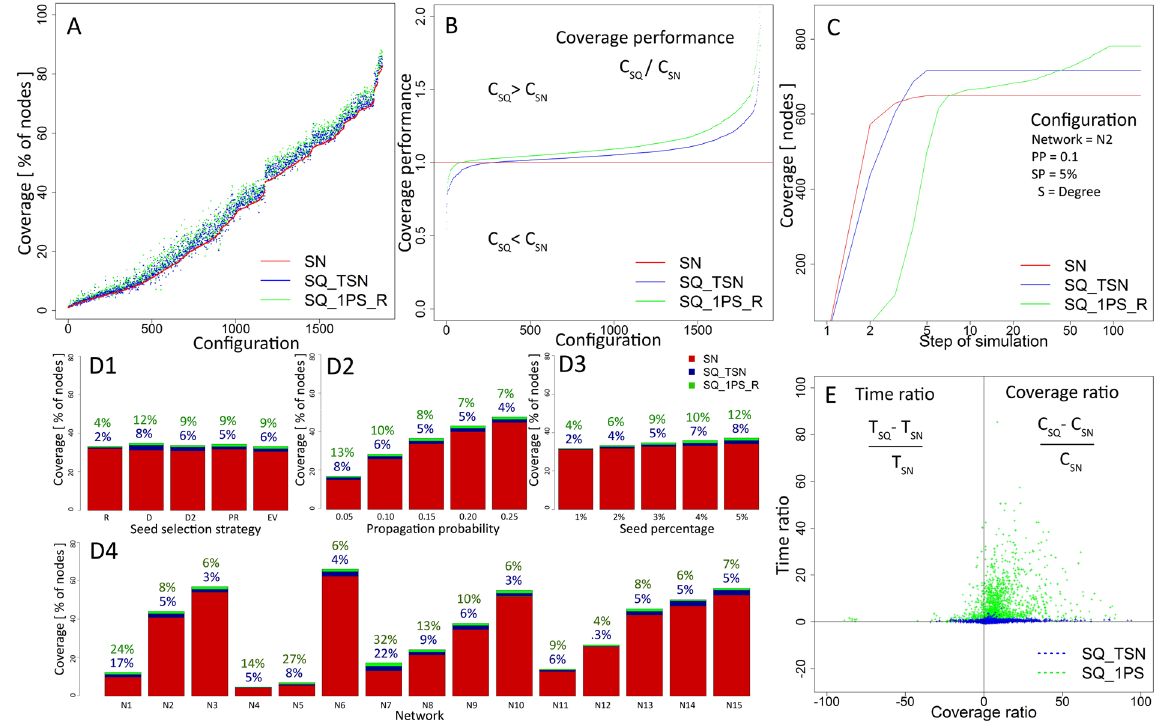
Figure 2. ( A ) Average coverage from all 1,875 configurations for k = 1 per stage seeding (SQ_1PS_R) and the sequential approach based on single stage time reference (SQ_TSN), compared with the single stage method (SN) for all simulation cases ordered by single stage coverage; ( B ) Performance of k = 1 per stage seeding (SQ_1PS_R) and reference time based seeding (SQ_TSN) in the relation to single stage (SN) for all configurations; ( C ) Cumulative coverage results from 100 steps of simulation with degree based ranking ( D ) for network N2 with propagation probability PP = 0.1 and seeding percentage SP = 5%; ( D1 ) Coverage increase for SQ_1PS_R and SQ_TSN based on various seed ranking methods: random R, degree D, second level degree D2, Page Rank PR, Eigenvector EV; red part shows single stage seeding (SN) coverage, blue part and font show sequential SQ_TSN improvement while green part and font show sequential SQ_1PS_R gain; ( D2 ) Coverage increase for SQ_1PS_R and SQ_TSN for all used propagation probabilities with values 0.05, 0.1, 0.15, 0.20 and 0.25; ( D3 ) Results for seed selection percentages from the range 1% to 5% for SQ_1PS_R and SQ_TSN; ( D4 ) Average coverage from single stage seeding together with coverage increase from sequential seeding SQ_1PS_R and SQ_TSN for networks N1–N15; ( E ) Distribution of simulation cases in terms of coverage and time ratios for k = 1 per stage seeding (SQ_1PS_R) and reference time based seeding (SQ_TSN) for all networks, where T SQ and C SQ denote time and coverage in appropriate sequential seeding: SQ_1PS_R or SQ_TSN, while T SN and C SN stand for time and coverage in single stage